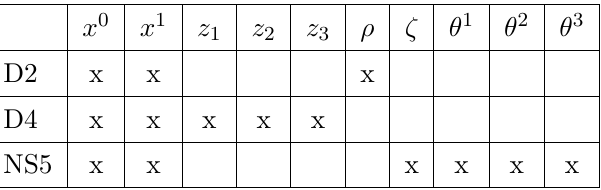
-BPS brane intersection underlying the geometry (4.1) with F = 0 . ( x 0 , x 1 ) are the Table 4 . 1 0 4 directions where the 2d dual CFT lives, ( z ) span the T 3 on which the D4-branes are wrapped, 1 , z 2 , z 3 ζ and θ i parameterise respectively the radial coordinate of AdS 3 and the S 3 , and ρ is the field theory